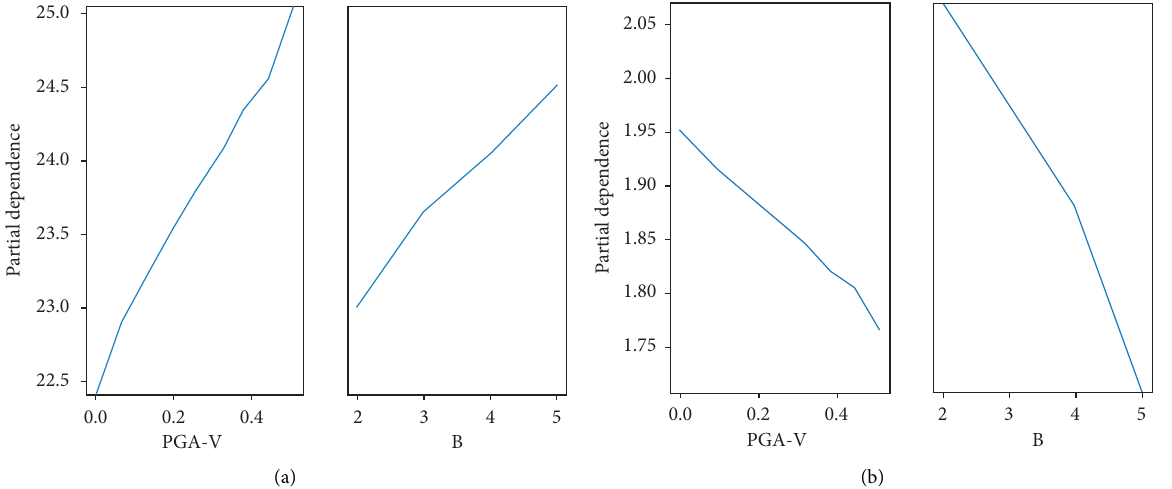
Figure 14: The partial dependence of vertical PGA (PGA-V) and bearing number ( B ) with (a) pier top displacement and (b) bearing